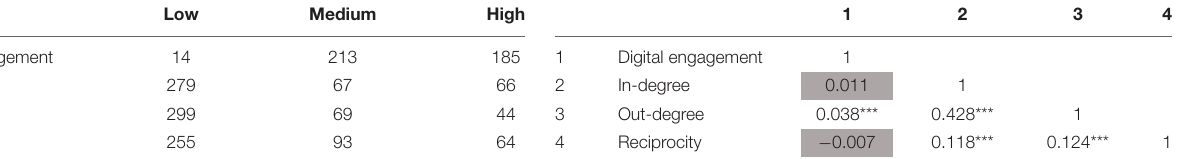
TABLE 2 | Categorization: low, medium, and high value. Low Medium